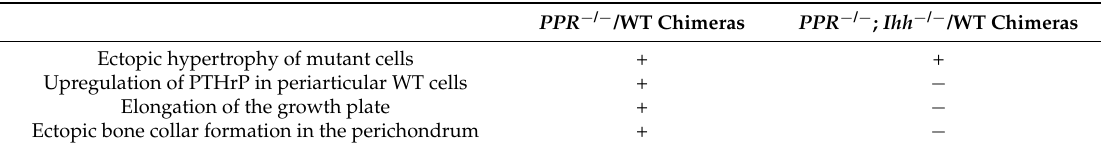
Table 1. Comparisonofphenotypesbetween PPR ´ / ´ /WTchimericand PPR ´ / ´ ; Ihh ´ / ´ /WTchimeric.mice. PPR ´ / ´ /WT